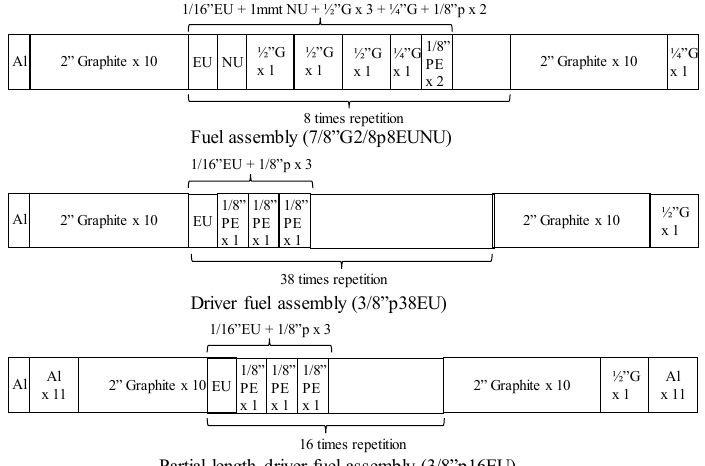
Figure 1. Configuration of fuel